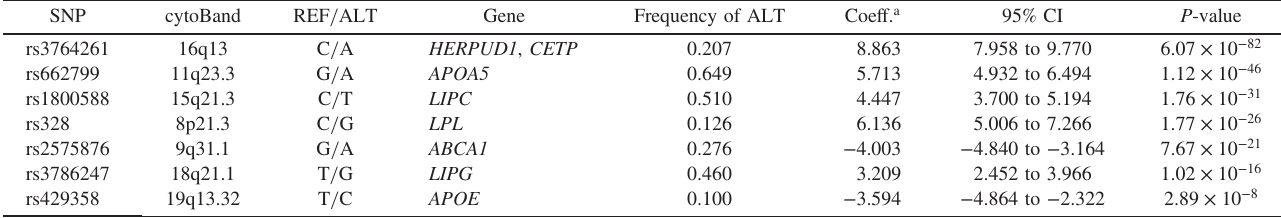
Table 3. Multivariate regression analysis between HDL-C levels and seven HDL-C related SNPs from the GWAS catalog SNP cytoBand REF / ALT Gene Frequency of